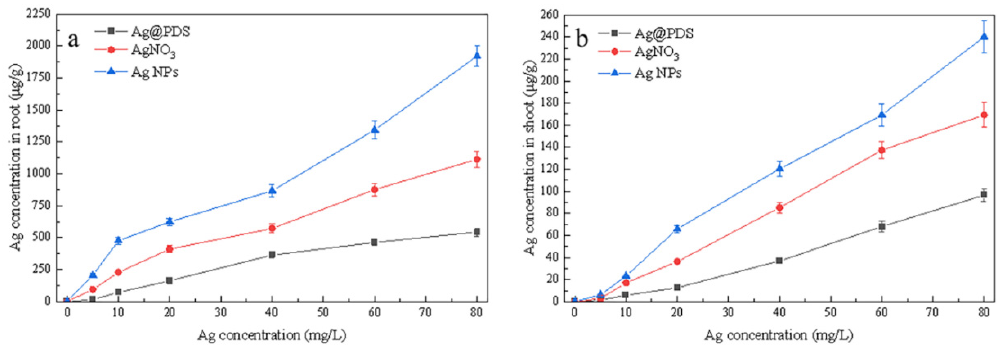
Figure 4. Ag content in the L. multiflorum root ( a ) and shoot ( b ) after 7 days exposure of Ag@PDS, AgNO 3 , and AgNPs.